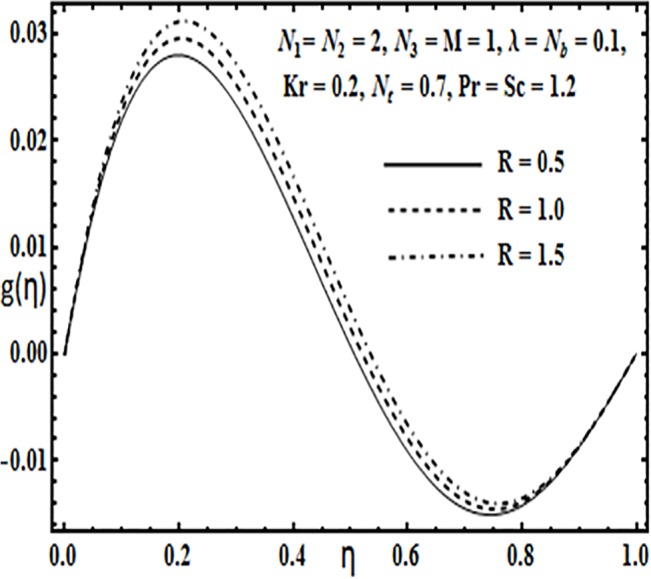
Effect of R on g(η).